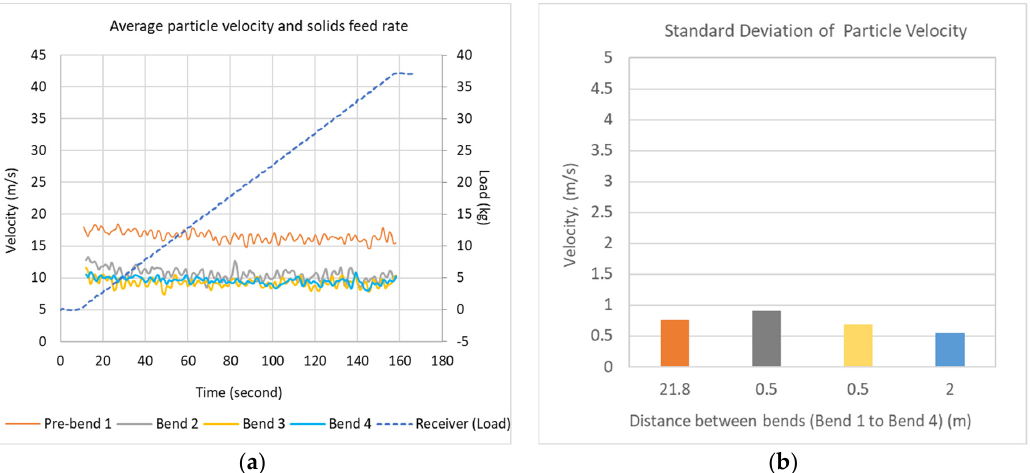
Figure 3. Measurement of localized particle velocity and average feed rate with 0.2 kg/s air flow rate and feeder speed of 5 RPM during conveying with bends in proximity; ( a ) Particle velocity at each bend, solid feed rate, ( b ) standard deviation in particle velocity measurement each second.